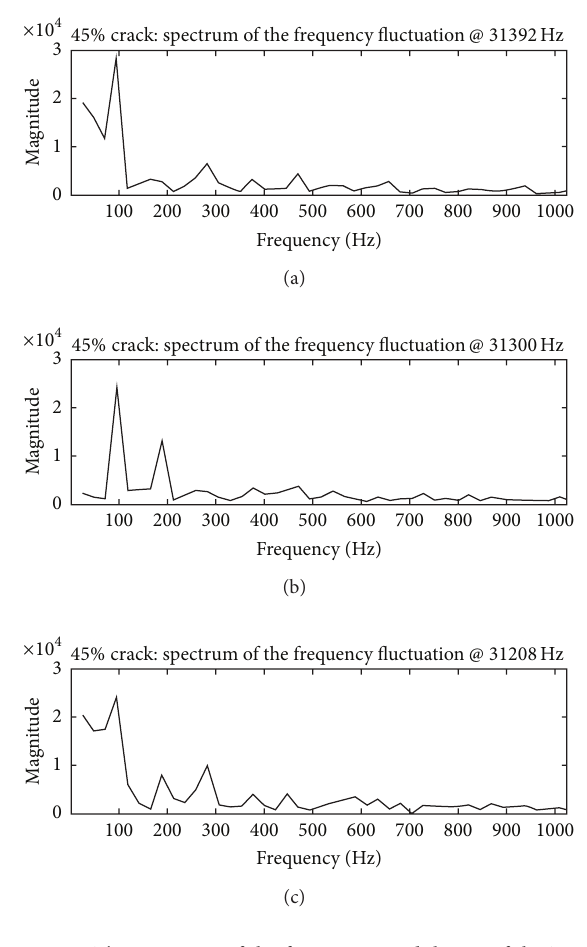
Figure 6: The spectrum of the frequency modulation of the ZAM transform at the corresponding VAM frequencies, that is, 31392 Hz (a), 31300 Hz (b), and 31208 Hz (c), for the crack size of 45%,